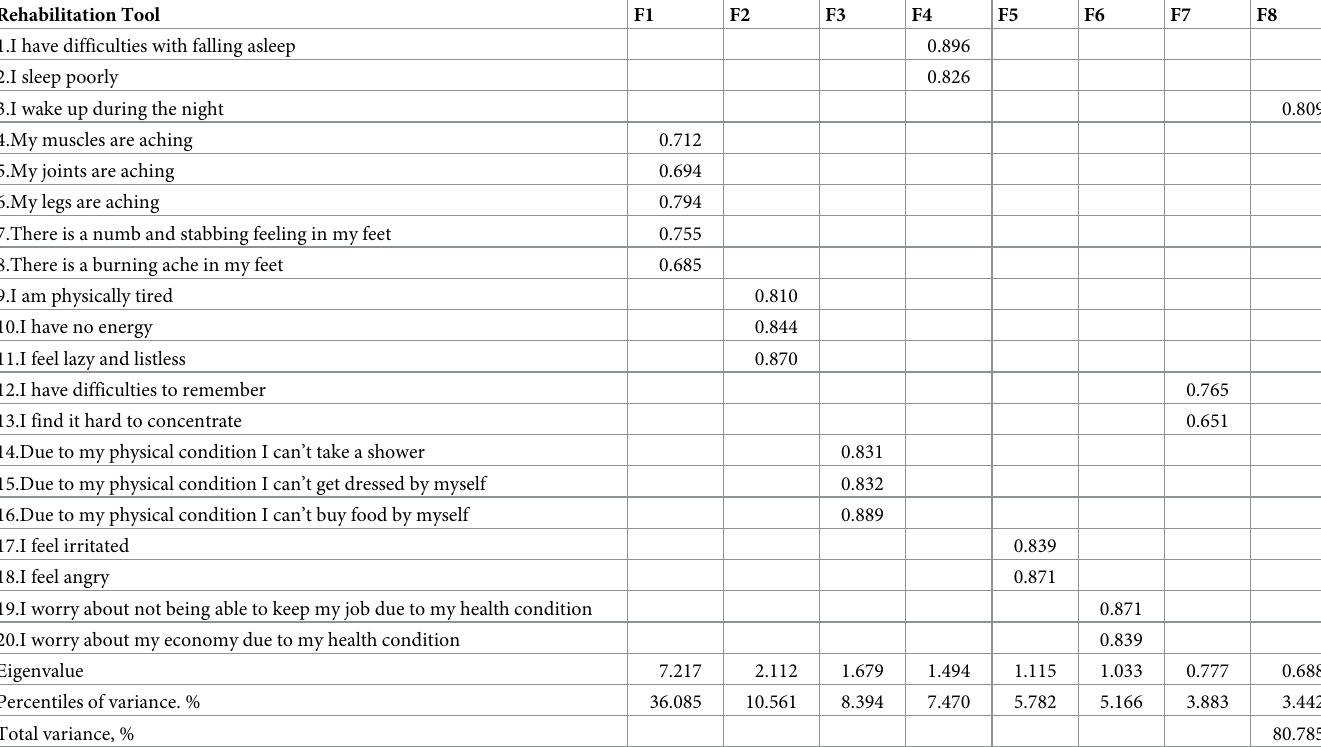
Table 3. Principle components analysis followed by varimax rotation factor loadings of Chinese organ transplant symptom and well-being instrument. Rehabilitation